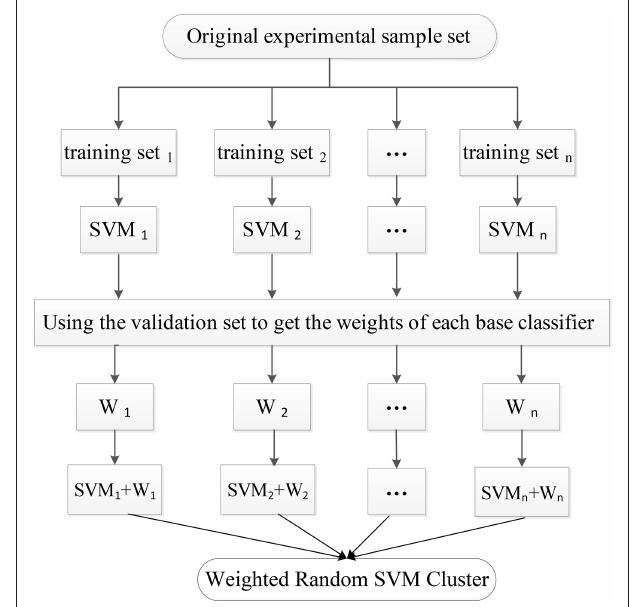
FIGURE 2 | The training process of the